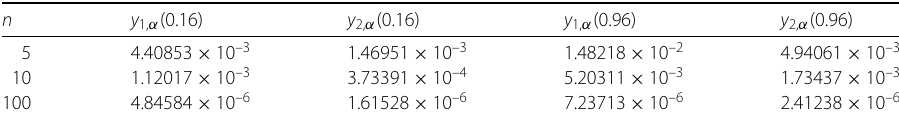
Table 9 The absolute errors of approximating (1,2)-system at various t and α = 0.5 n y 1, α